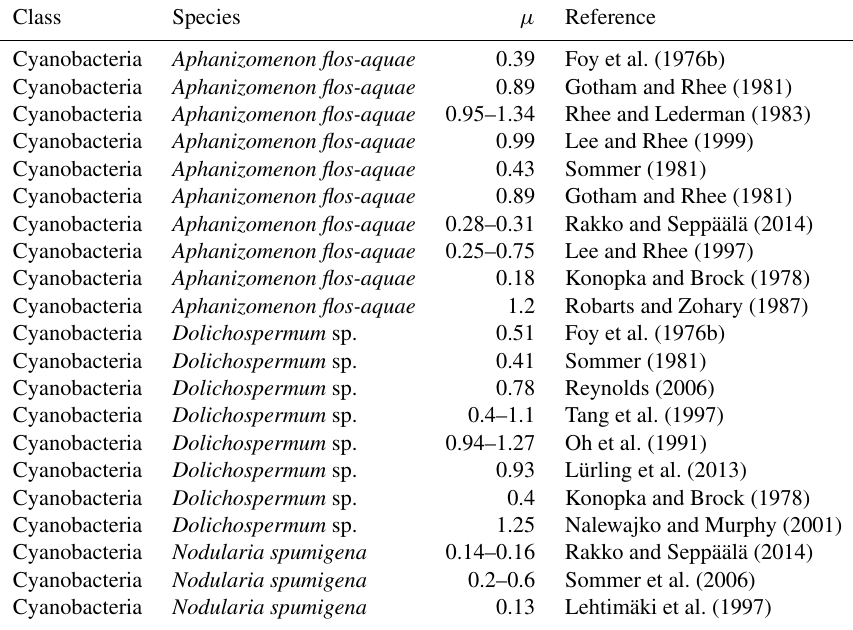
Table 5. Maximal growth rates ( µ ) of the studied cyanobacteria species.